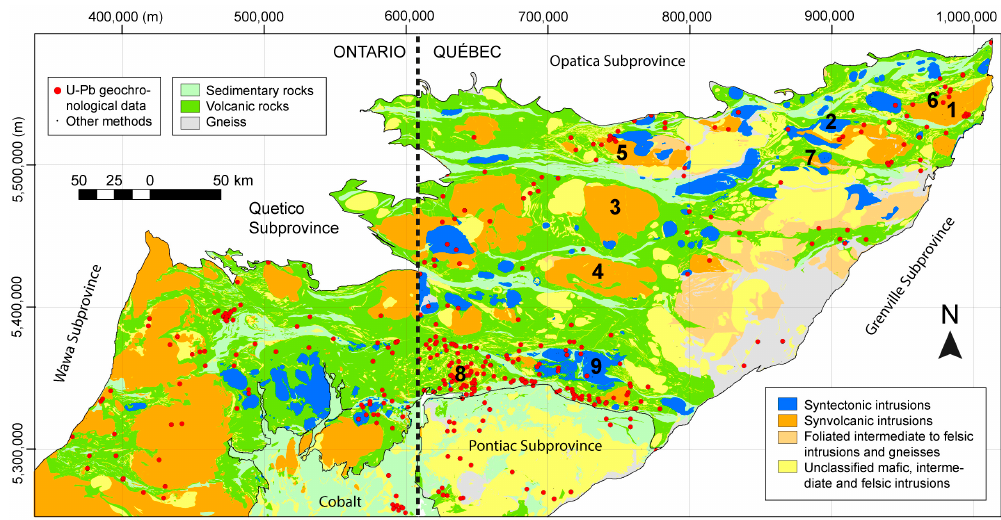
Figure 2. Geological map of the Abitibi Subprovince displaying intrusions of the synvolcanic and syntectonic periods. The map is modified from the MERN and OGS dataset, and the projection is UTM NAD83 Zone 17N. Numbers locate the Chibougamau pluton (1), the Ouest granodiorite (2), the Marest (3) and Bernetz (4) batholiths, the Rivière Bell (5), Lac Doré Complex (6), and Opawica River (7) layered intrusions, as well as the Powell, Flavrian and Dufault plutons (8) and the Lacorne pluton (9). In the legend for geochronological data, ‘other methods’ refers to Ar/Ar, K/Ar, Sm/Nd, Pb/Pb, and Rb/Sr data (cooling ages, age of peak metamorphism, etc.).